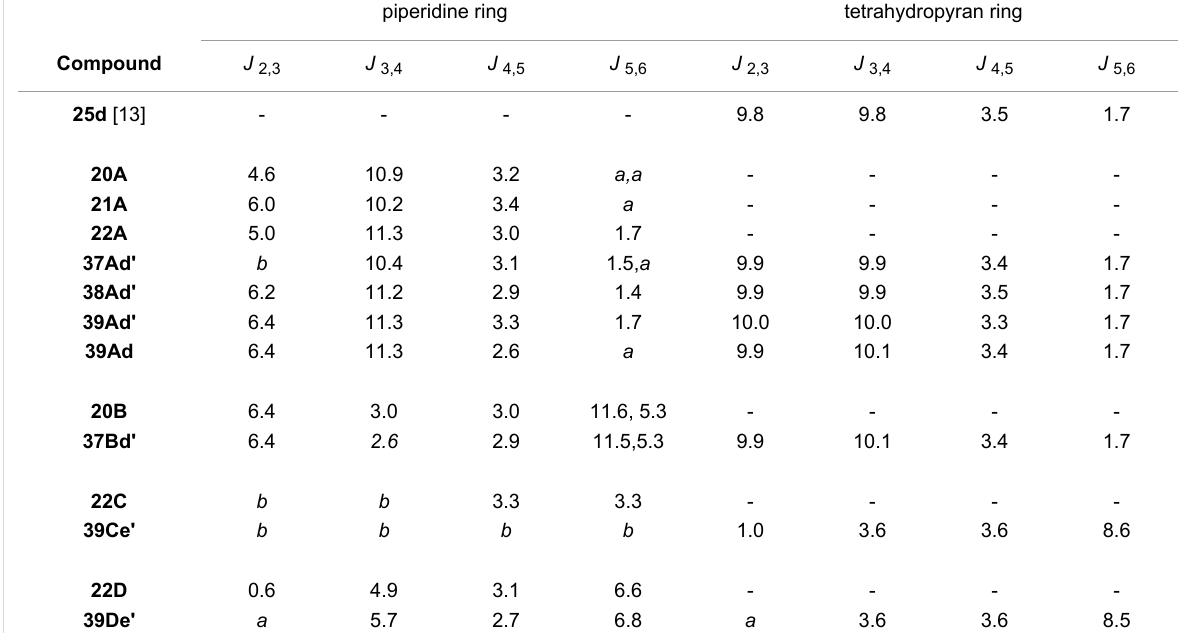
Table 2: Diagnostic coupling constants (Hz) in the tetrahydropyran 25d , the piperidines 20–22 and aza- C -linked disaccharide derivatives 37–39 piperidine ring tetrahydropyran ring